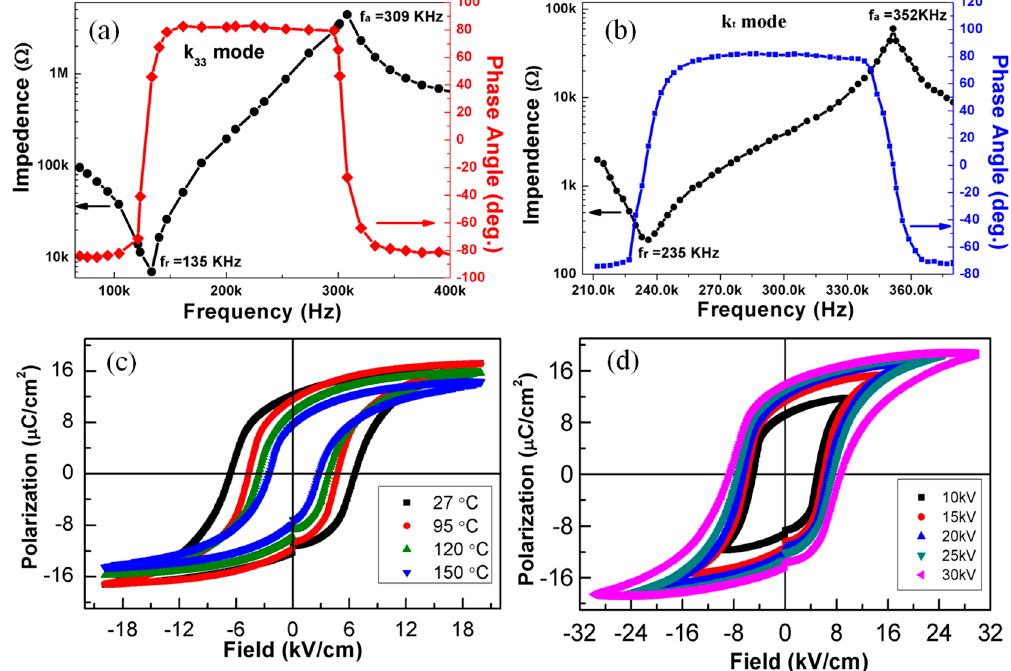
Figure 4. ( a ) Longitudinal impedance and phase angle as a function of frequency based on resonance and anti-resonance frequencies for [001]-oriented bar PZN-9PT crystals; ( b ) Thickness impedance and phase angle as a function of frequency for [001]-oriented square PZN-9PT crystals; ( c , d ) P – E loops of [001]-oriented PZN-9PT crystal at different temperatures and electric fields, respectively.